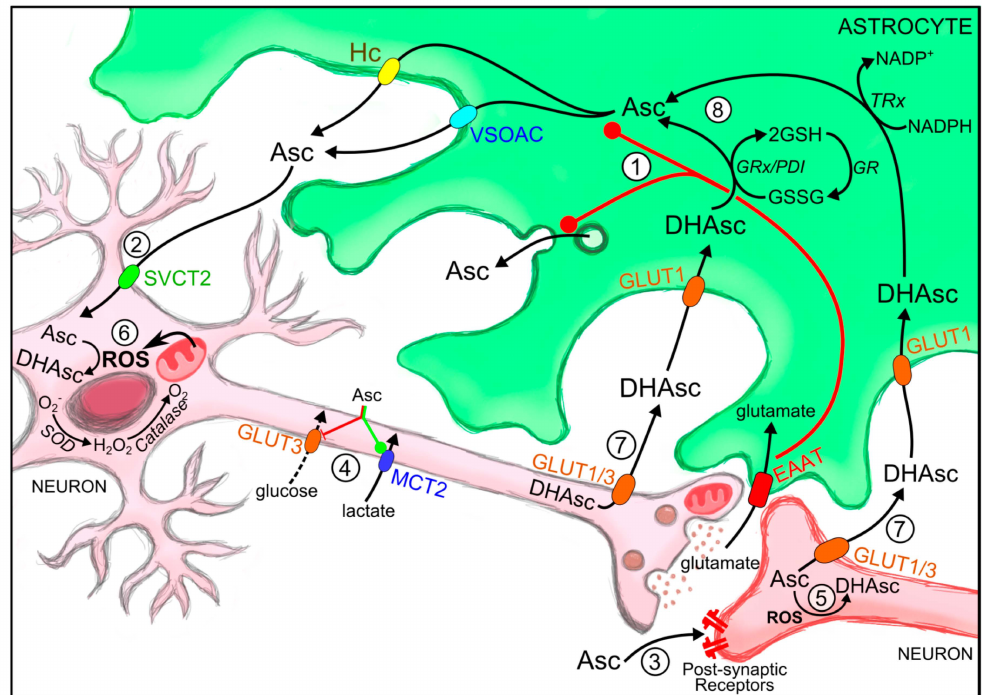
Figure 1. Roles of ascorbic acid during synaptic activity and astrocyte-mediated recycling. (1) During synaptic activity glutamate released into the synaptic space is taken up by astrocytes, where it stimulates ascorbic acid release from these cells through different hypothesized mechanisms (after astrocyte swelling by VSOAC induced via GLAST glutamate-aspartate transporter; Connexin-hemichannels; or through exocytosis of secretion vesicles); (2) Astrocyte-released ascorbic acid is taken up by neurons through SVCT2; (3) It participates as a neuromodulator (glutamatergic and GABA-ergic neurotransmission); (4) Regulates neuronal metabolic substrate preference via specific GLUT3 inhibition (metabolic switch). Reactive oxidant species (ROS) produced during synaptic activity (5) and neuronal metabolism (6) oxidize ascorbic acid to DHAsc; (7) DHAsc is released from neurons and is taken up by astrocytes through glucose transporters (GLUTs); (8) Astrocytes can reduce oxidized ascorbic acid via direct reaction with glutathione o via glutathione-dependent reductases such as glutaredoxin and protein disulfide isomerase. AMPAR, (2-amino-3-(3-hydroxy-5-methyl-isoxazol-4-yl) propanoic acid receptor; Asc, ascorbic acid; DHA, dehydroascorbic acid, oxidized ascorbic acid; EAAT, excitatory amino acid transporter; GABA ( γ amino butyric acid); GLAST, (glutamate transporter in astrocytes); GLUT3, glucose transporter isoform 3; GSH, reduced gluthatione; GSSG, oxidized gluthatione; MCT, monocarboxylate transporter; ROS, reactive oxygen species; SVCT2, sodium-vitamin C transporter isoform 2; VSOAC, Volume-sensitive organic osmolyte-anion